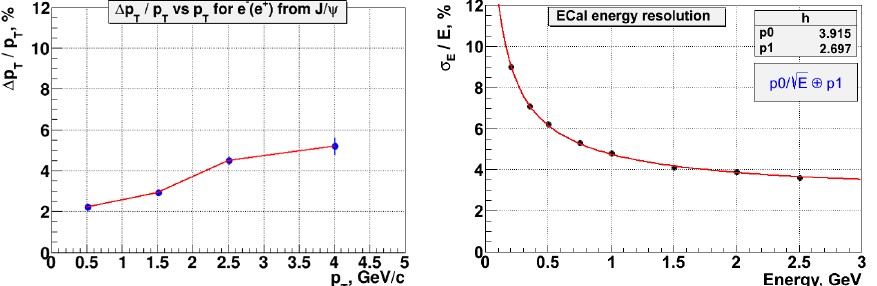
Figure 4. Left) ∆ηp T /ψ decays is quite high (~80% for |p T versus p T for electrons and positrons with |η| < 1.5 from J/ψ decays is quite high (~80% for |ψ decays. Right) energy resolution (σ E /ψ decays is quite high (~80% for |E) of the EMC for photons and electrons as a function of their energy